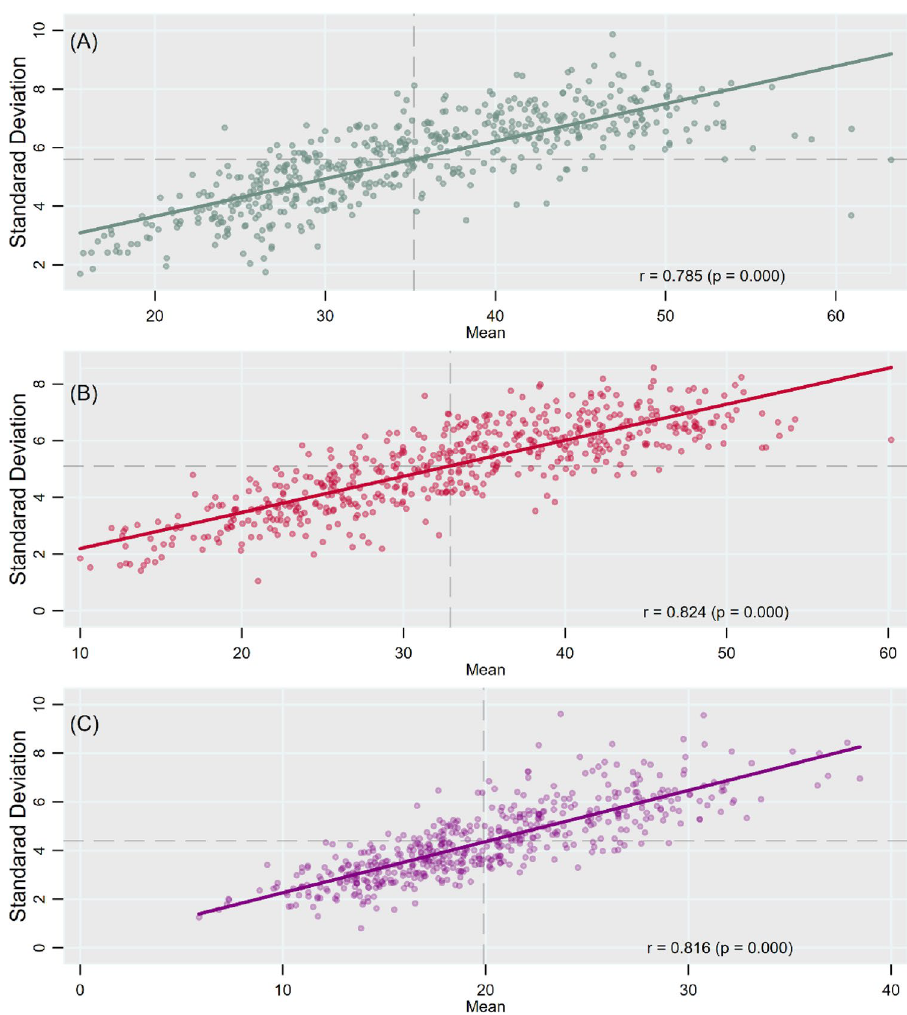
Figure 6. Scatter Plots showing correlation between mean and SD of child anthropometric failures across PCs for ( A ) stunting; ( B ) underweight; ( C ) wasting, India, NFHS